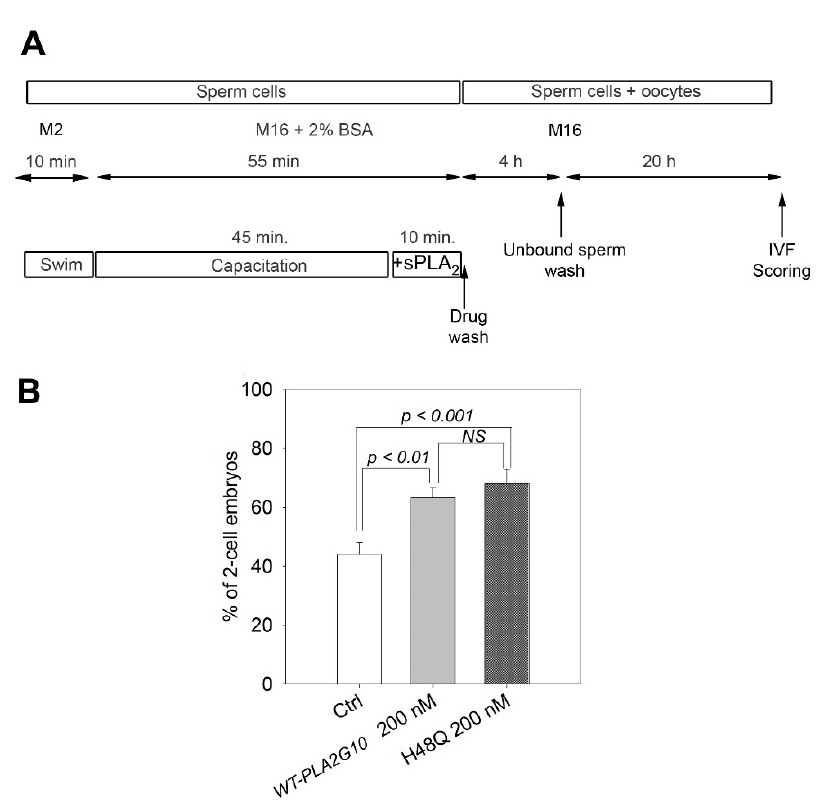
Figure 3. The inactive mutant H48Q-PLA2G10 is as efficient as the catalytic WT-PLA2G10 enzyme in boosting in vitro fertilization of gametes from C57BL/6 mice. ( A ) Schematic drawing of IVF experiments. Sperm were capacitated for a total duration of 55 min in M16-2% BSA and incubated at the end of the capacitation period with WT-PLA2G10 or its catalytic inactive mutant H48Q-PLA2G10 (noted H48Q). After treatment, sperm were washed out by centrifugation to remove unbound drugs, PLA2G10 catalytic products and all acrosomal compounds released during sPLA 2 -induced AR. Finally, washed sperm were introduced into droplets containing MII oocytes (20–109 oocytes per experiment). After 4 h of gamete mixing, unbound sperm were washed away, and IVF outcomes were scored at 24 h. ( B ) Comparison of IVF outcomes obtained with sperm treated with either 200 nM WT-PLA2G10 (n = 7) or 200 nM H48-PLA2G10 (n = 7). n represents the number of biological replicates. The statistical difference in the mean was assessed using t -test. p -value, as indicated. NS, not significantly different.